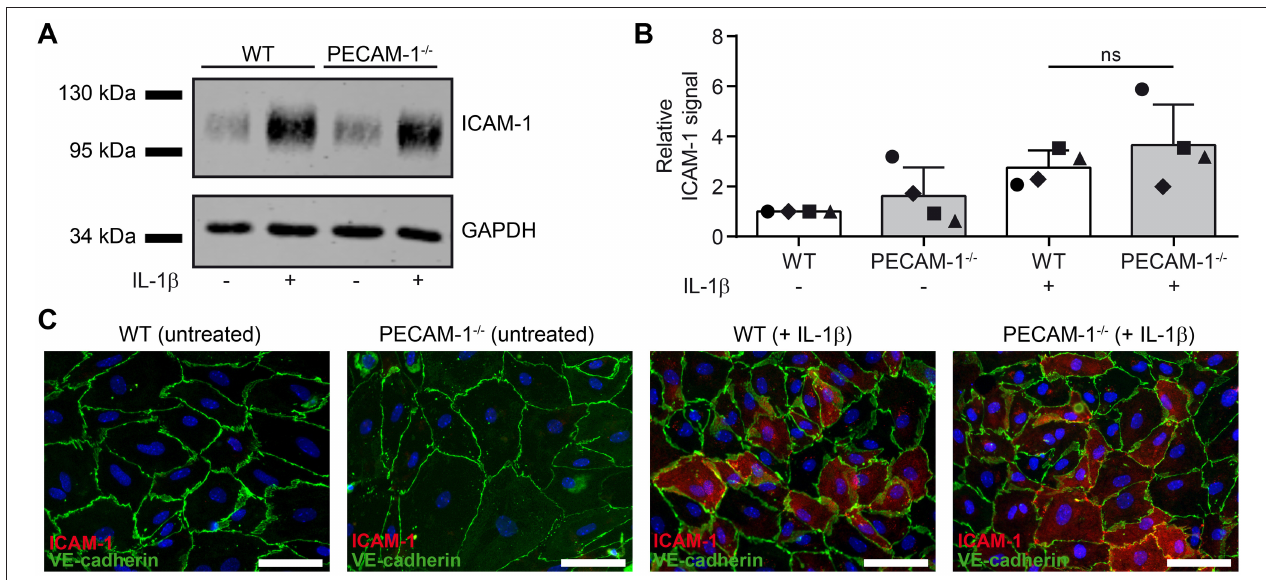
FIGURE 7 | Lack of endothelial PECAM-1 does not affect expression levels of ICAM-1 on pMBMECs. (A) WT and PECAM-1 − / − pMBMEC monolayers were treated for 16h either with IL-1 β (20ng/ml) or left unstimulated. Western blots of cell lysates were incubated with anti-ICAM-1 rabbit serum and rabbit anti-GAPDH antibody. One representative experiment out of 4 is shown. (B) Quantified ICAM-1 signals were normalized to the reference protein GAPDH. For each experiment, normalized signals were further related to the unstimulated WT sample. Each individual data point is shown and shapes correlate to the respective independent experiments ( n = 4). Reported statistics result from unpaired, two-tailed Student’s t -test. Test statistics: p = 0.348, t (6) = 1.018, d = 0.831. Error bar, ± SD; ns, not significant. (C) Untreated and IL-1 β -stimulated VE-CadGFP endothelial monolayers stained for ICAM-1 expression (rat hybridoma supernatant 25ZC7). Blue, cell nuclei stained with DAPI; Scale bar, 60 µ